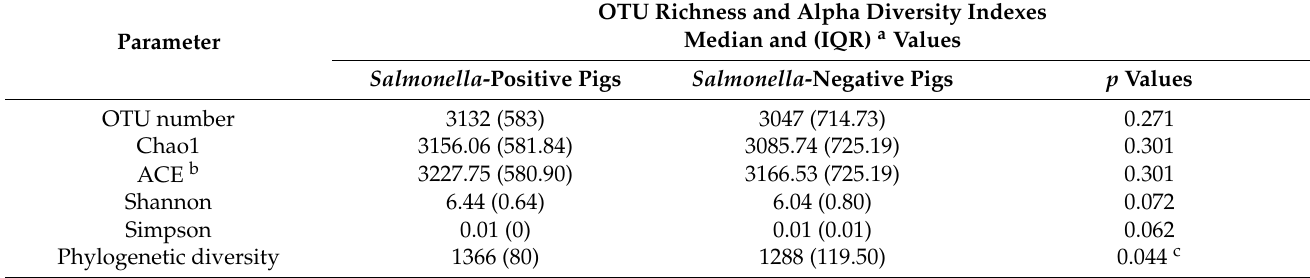
Table 4. Operational taxonomic units (OTUs)’ richness and alpha diversity indexes estimated in the gut microbiota of Salmonella -positive and Salmonella -negative